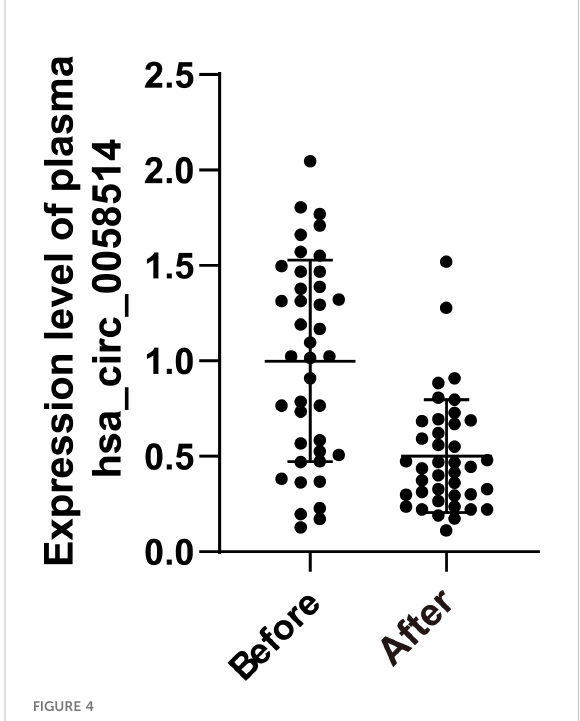
FIGURE 4 The dynamic monitoring effect of hsa_circ_0058514. The